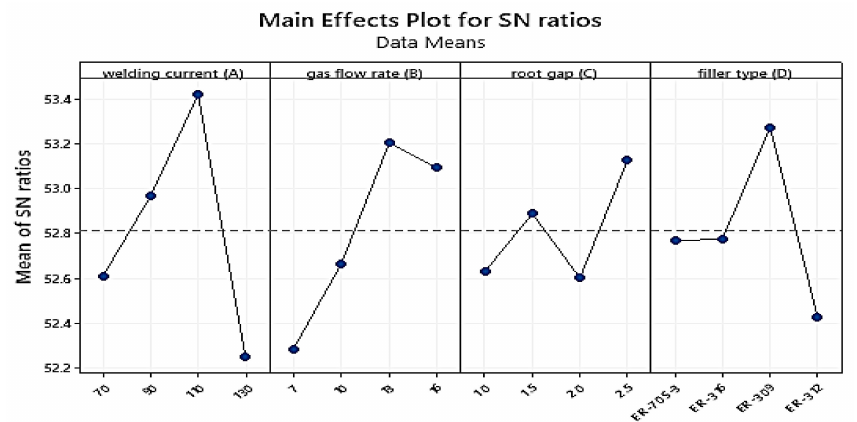
Figure 19. Main effect plot for S/N ratios for Tensile Strength. Table 10. Analysis of variance (ANOVA) for Tensile